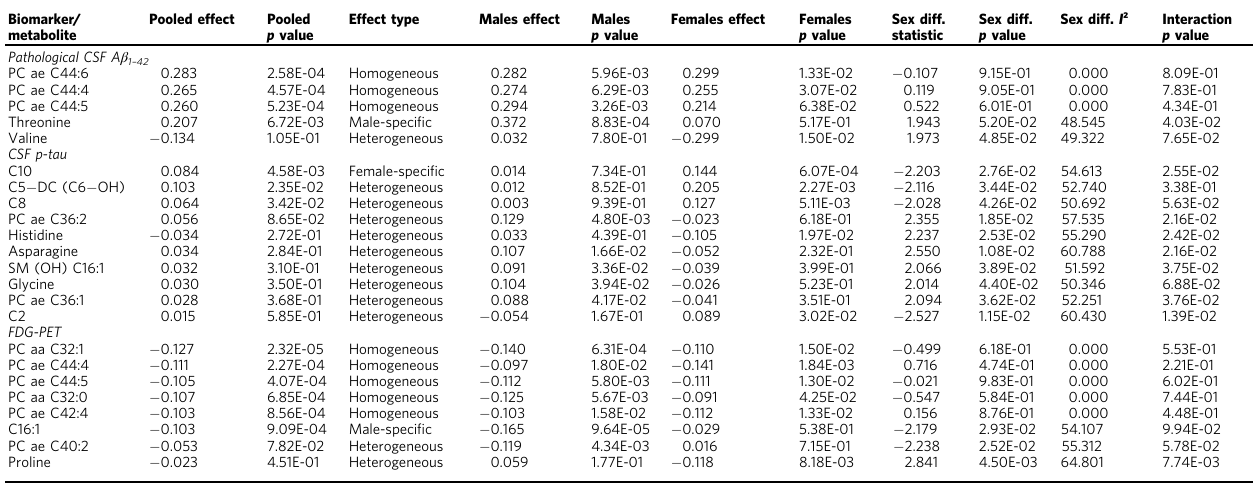
Table 2 Association results and heterogeneity estimates for metabolites in relation to A-T-N biomarkers strati fi ed by sex. Biomarker/